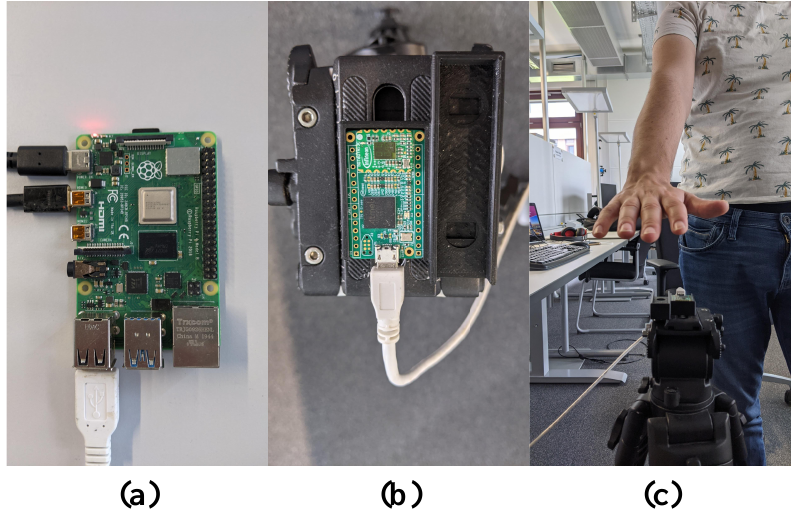
Figure 12. Data collection setup; ( a ) Raspberry Pi4; ( b ) 3D-printed case and radar board; and ( c ) tripod with 3D-printed case and radar